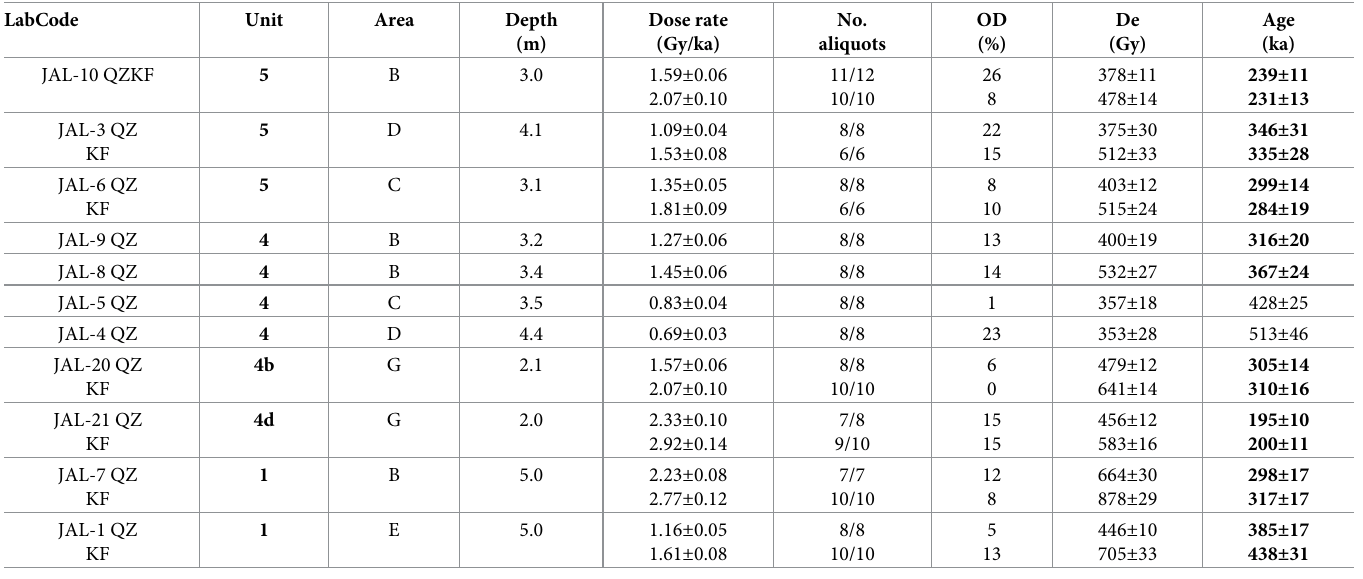
Table 5. Field data and luminescence ages, following the measurement protocols detailed in 2.